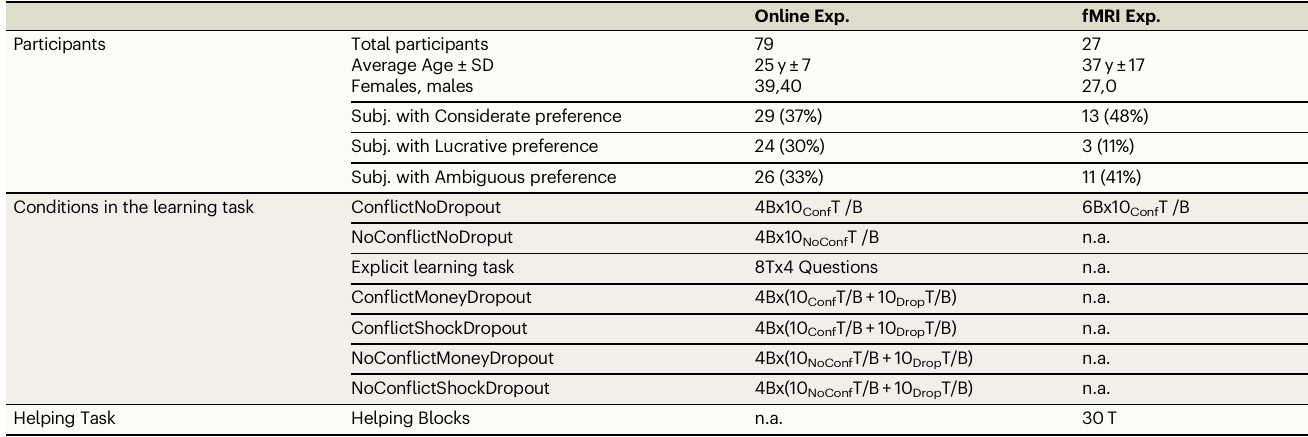
Table 1 | Participants and task-conditions overview